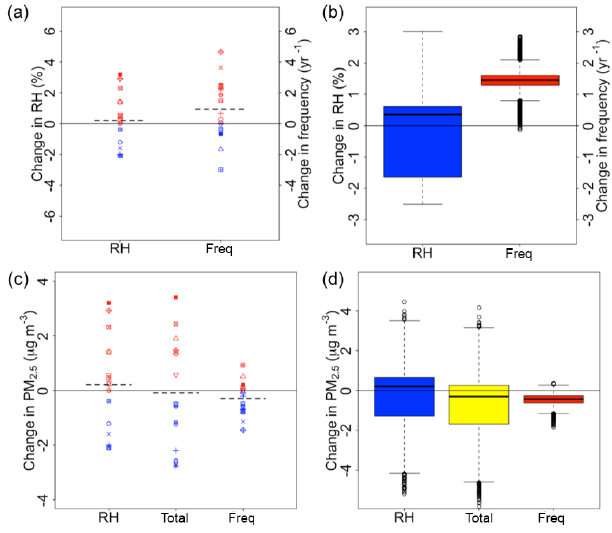
Figure 8. Projected changes in PM 2 . 5 from 2000 to 2050, as cal- culated from meteorological outputs from the CMIP5 model en- semble. (a) Future projections of mean relative humidity (RH, %) and median synoptic frequency of springtime Siberian High (yr − 1 ) as computed by 15 CMIP5 models. (b) Statistical distributions of CMIP5-projected RH and synoptic frequency as computed by model weighting algorithm of Tebaldi et al. (2005). (c) Changes in PM 2 . 5 (µgm − 3 ) from 2000 to 2050 based on climate projections from 15 models and statistical sensitivities from our multiple linear regression model. (d) Statistical distributions of projected PM 2 . 5 based on Monte Carlo sampling of all possible uncertainty spaces. Dashed lines indicates the simple ensemble mean of the changes, red dots indicate positive changes, and blue dots indicate negative changes. The label “RH” indicates changes associated with rela- tive humidity, “freq” indicates changes associated with frequency of cold fronts from the Siberian High, and “total” denotes the sum of the